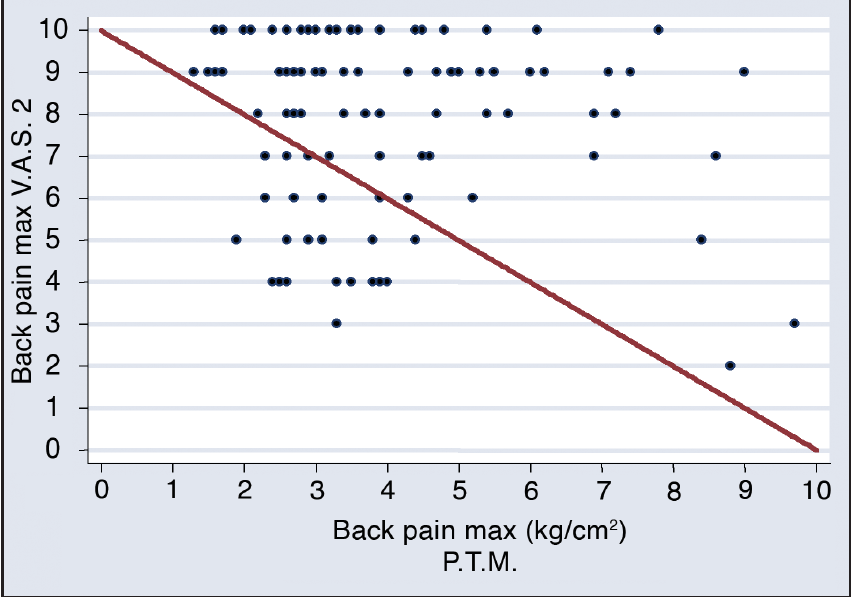
Figure 2: Scatter plot of the maximum pressure pain vs the patient perception on the